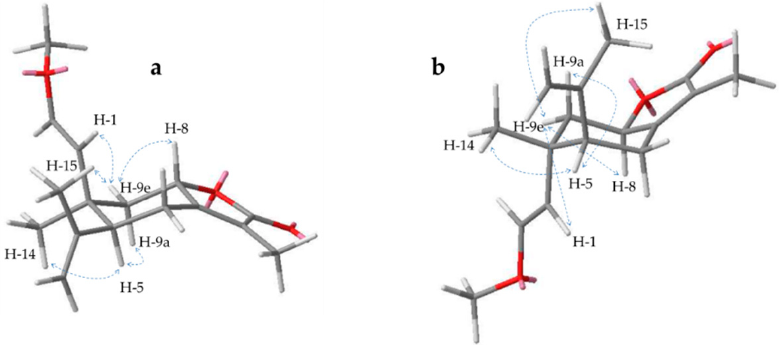
Figure 7. Key NOESY correlations for compound 15 in rel-5S,8S,10S ( a ) and rel-5S,8R,10R ( b ) configuration.